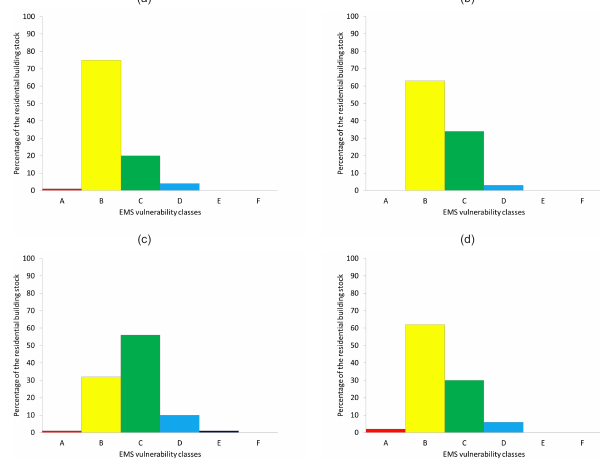
Figure 6. Vulnerability composition models (as a percentage of the vulnerability classes of EMS-98) for the classified urban typology strata of Cologne as outlined in Fig. 5: (a) mixed built-up area; (b) row houses, detached; (c) multi-family houses, buildings in blocks; (d) single-family houses and multi-family houses,